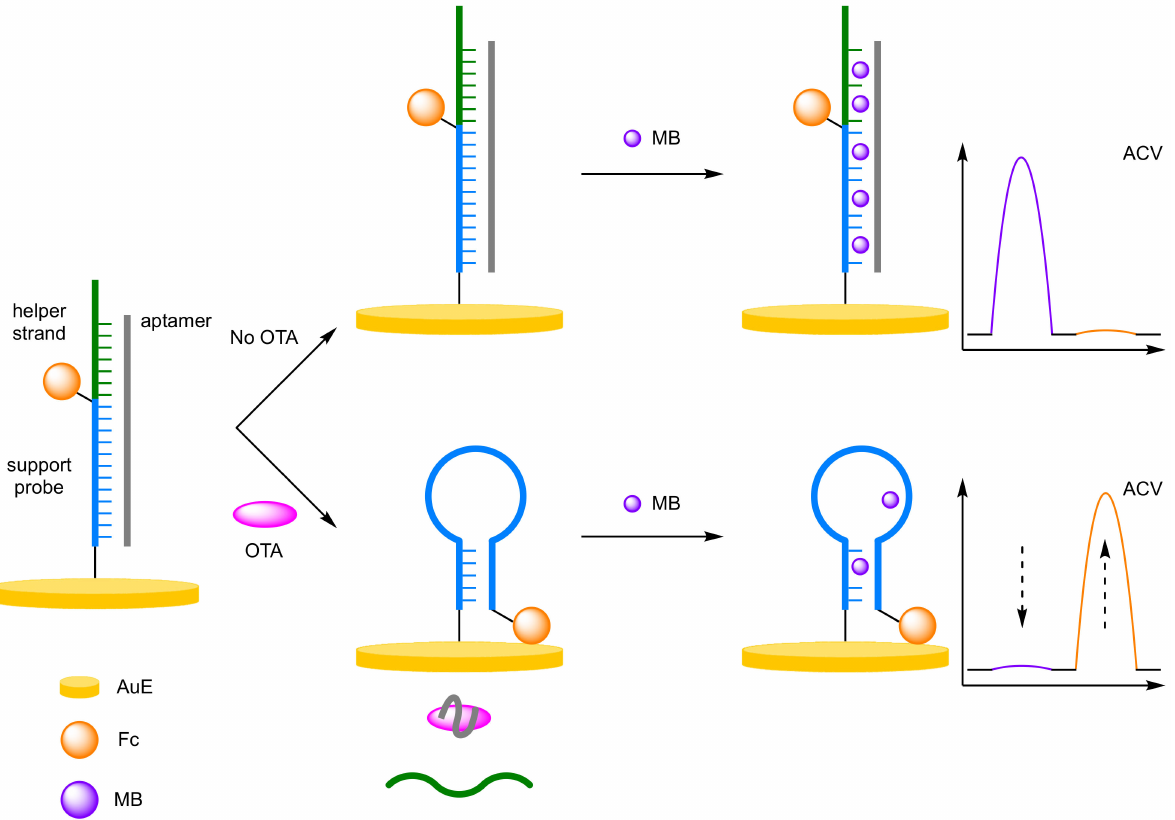
Figure 23. Schematic representation of multiple label intercalation-mediated amplification aptasensor for the detection of Ochratoxin A